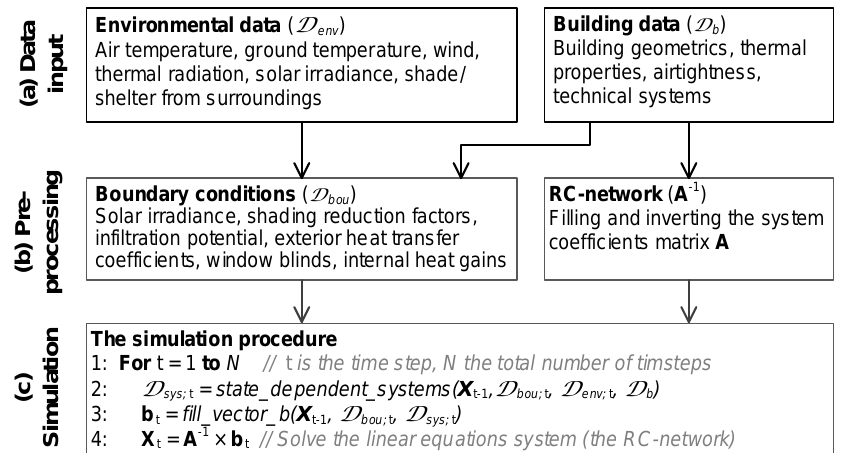
Figure 1. Process from data input ( a ) to pre-processing ( b ) and to the simulation procedure ( c